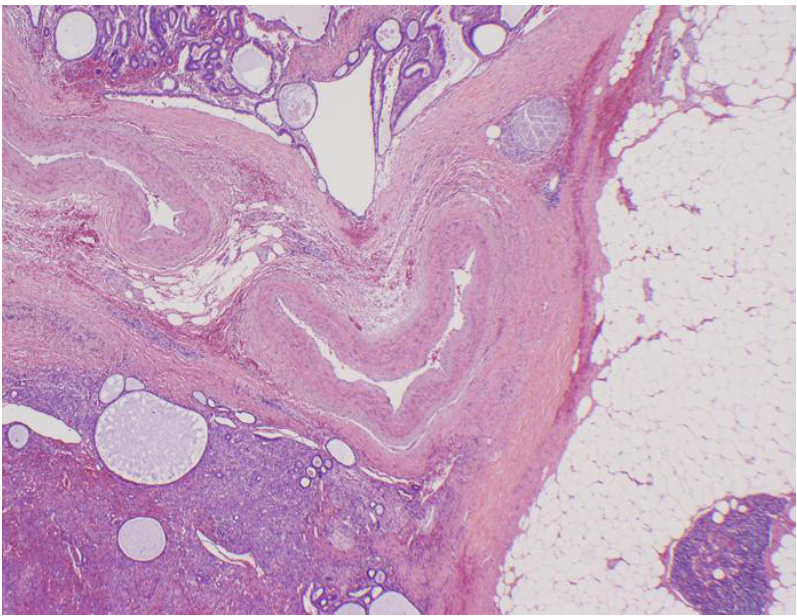
FIGURE 4. Section of ureter with endometrioid adenocarcinoma arising in a background of endometriosis (lower left corner).